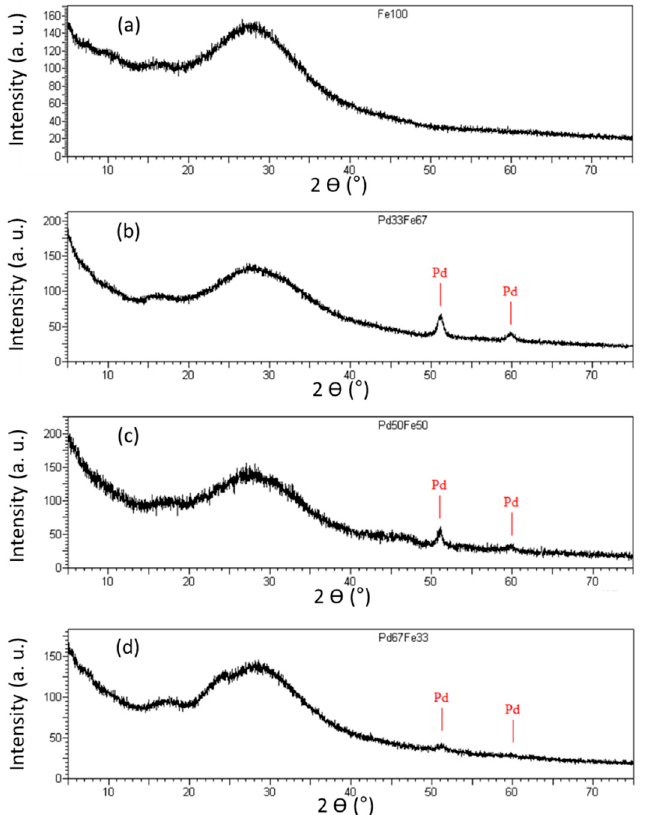
Figure 2. XRD patterns of ( a ) Fe100, ( b ) Pd33Fe67, ( c ) Pd50Fe50 and ( d ) Pd67Fe33 samples. Reference peaks corresponding to Pd are denoted on the fi gures.